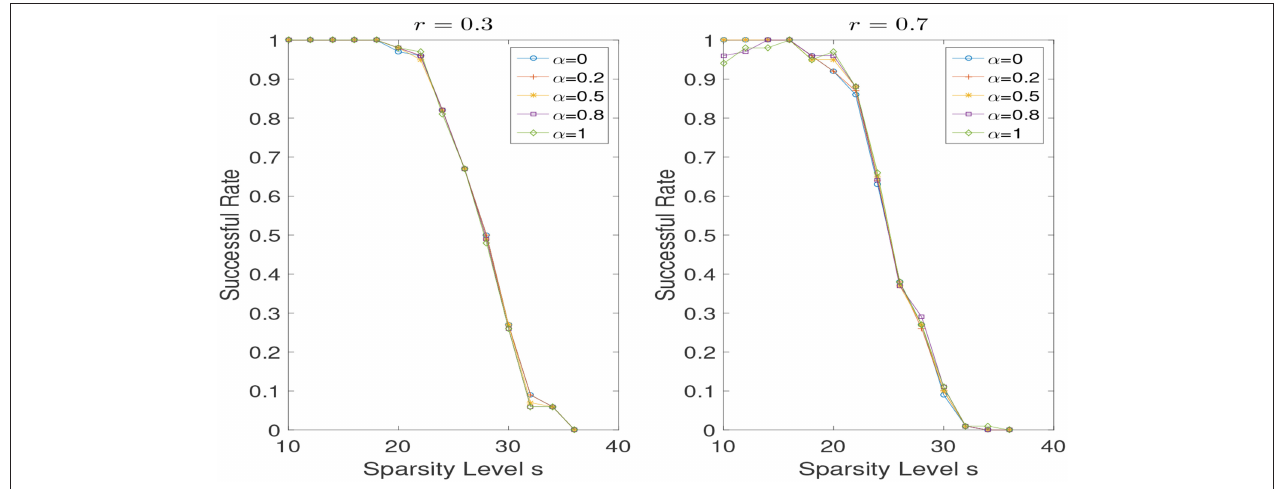
FIGURE 2 | Successful recovery rate for different α with r